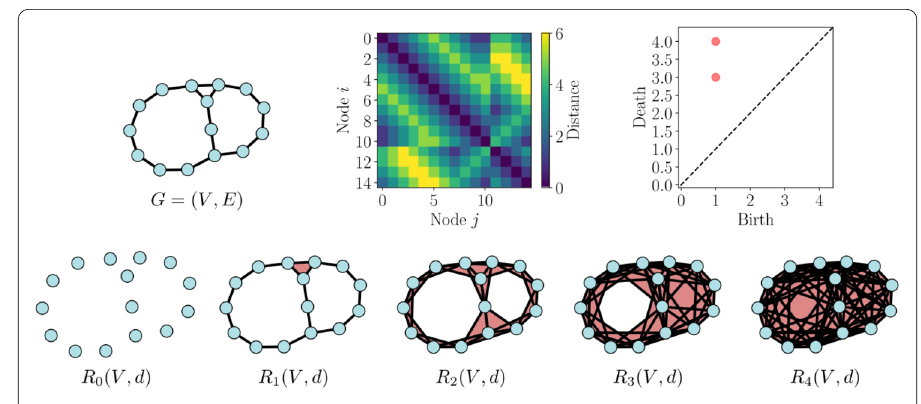
Figure 1 An example of a Rips filtration where the input is the shortest path distance on an example graph G . The persistence diagram in the top right is for standard persistence rather than zigzag as will be